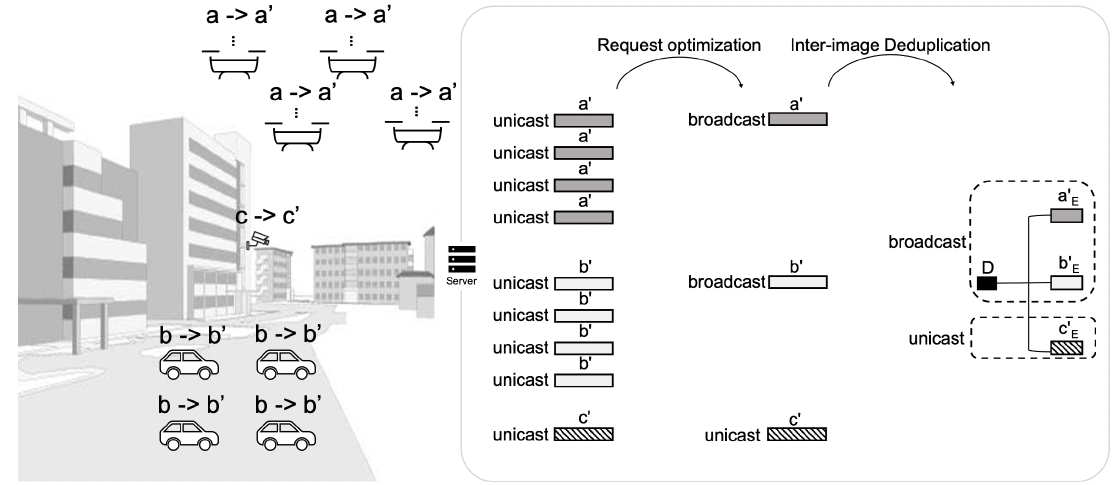
Figure 8. Example of deduplication of system